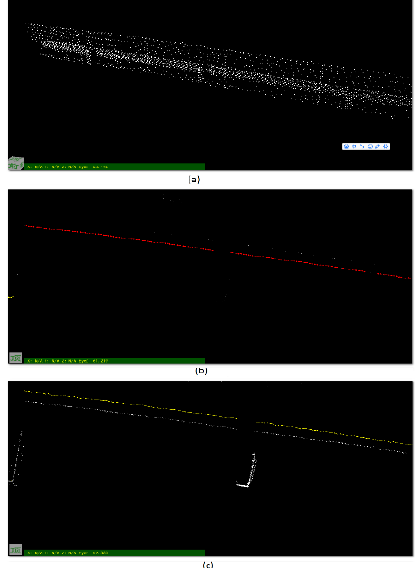
Figure 3. Guard net and isolation